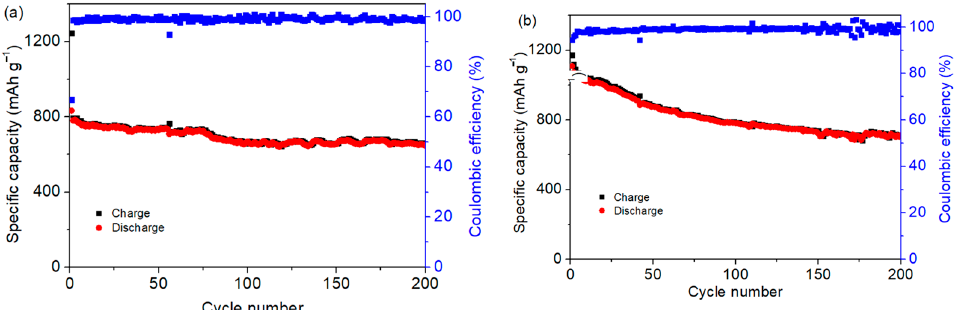
Figure 8. Specific capacities of Co 3 O 4 /S-infilled microcapsules when cycling at different temperatures of ( a ) − 10 °C and ( b ) 50 °C at 0.5C.